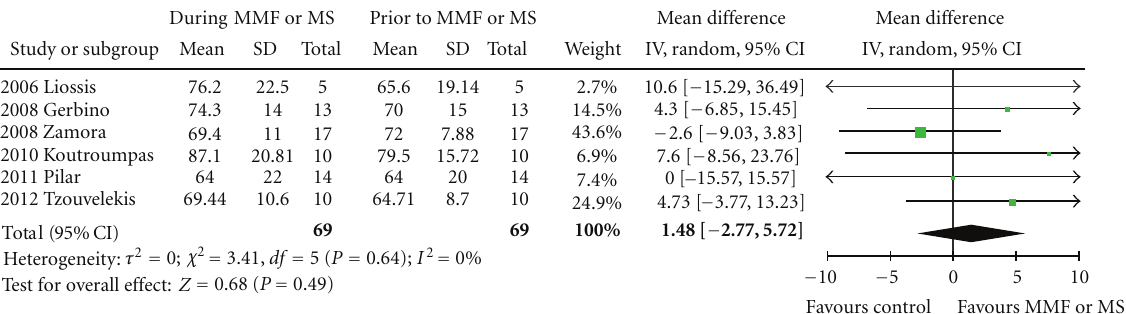
Figure 1: Forest plot of pooled data on FVC prior (favours control arm) and during treatment with MMF or MS (favours MMF or MS arm). Abbreviations: CI: confidence interval, DL CO : di ff using capacity for carbon monoxide, MMF: mycophenolate mofetil, MS: mycophenolate sodium, and SD: standard deviation.